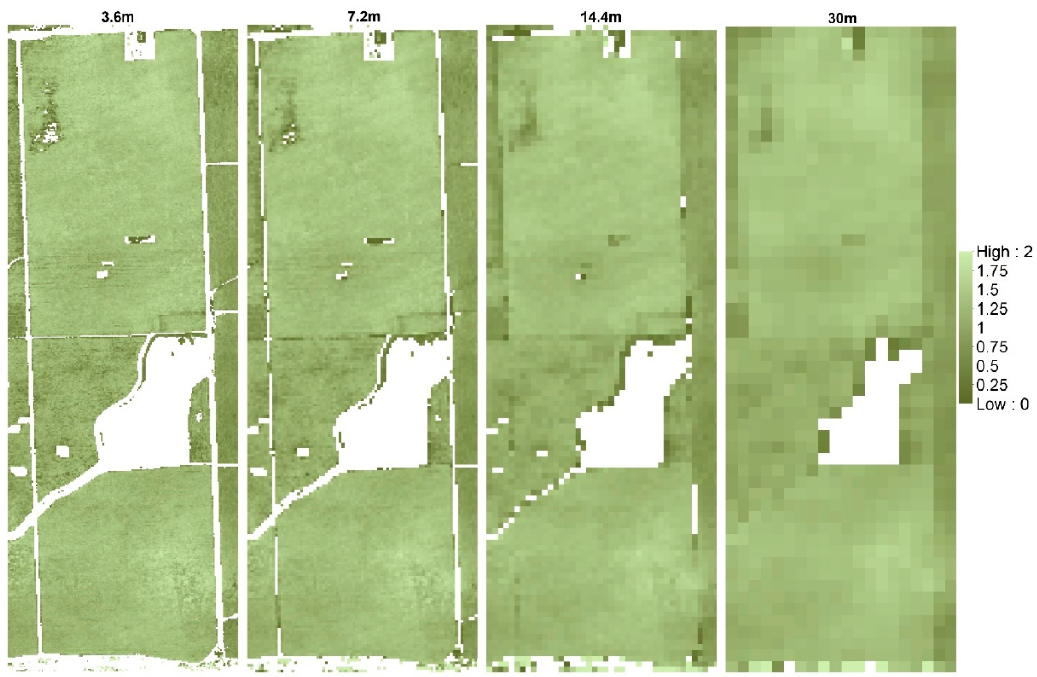
Figure A1. Example of modeled h c (m) across different spatial domains for 09 August 2014.